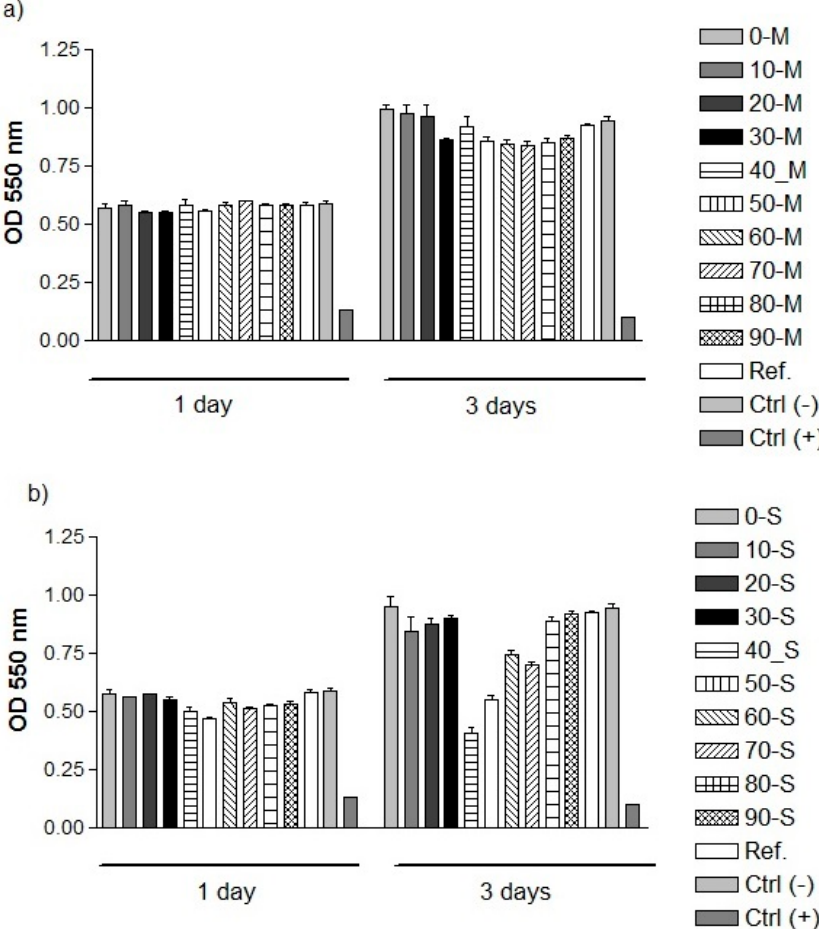
Figure 7. Cell viability/ proliferation of MC3T3-E1 pre-osteoblasts grown in the extraction media of marble- ( a ) and seashell- ( b ) derived powdered samples, as assessed by MTT assay (n = 3, mean ± SD).